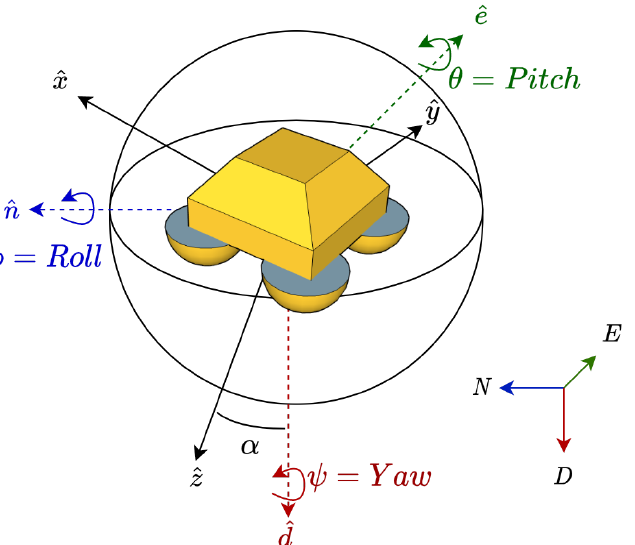
Figure 3. Fixed and moving-body (buoy’s) coordinate systems used: the fixed coordinate system is the right-handed north–east–down (NED) system (dashed arrows with unitary vectors ˆ n , ˆ e , and ˆ d plotted in blue, green, and red, respectively). The buoy’s coordinate system is denoted as XYZ (solid arrows with unitary vectors ˆ x , ˆ y , ˆ z ). α is the buoy’s eigenangle defined as the angle between unitary vectors ˆ d and ˆ z .